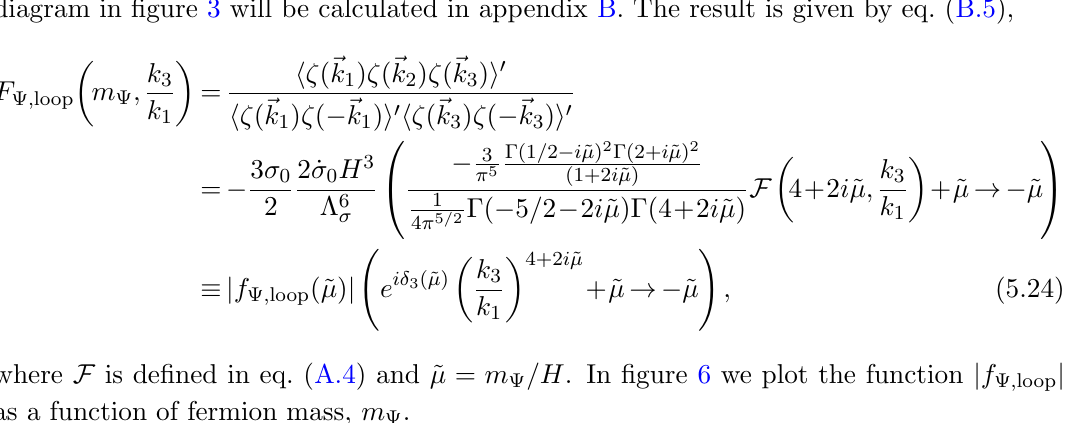
Figure 6 . The strength of NG for loop level charged fermion exchange as a function of fermion mass m (cid:9) for (cid:3) (cid:27) = 4 H and _ (cid:27) 0 = (cid:0) H 2 . The function j f (cid:9) ; loop (~ (cid:22) ) j is de(cid:12)ned in eq. (5.24). The dimensionless three point function, de(cid:12)ned in eq. (2.3), due to the double